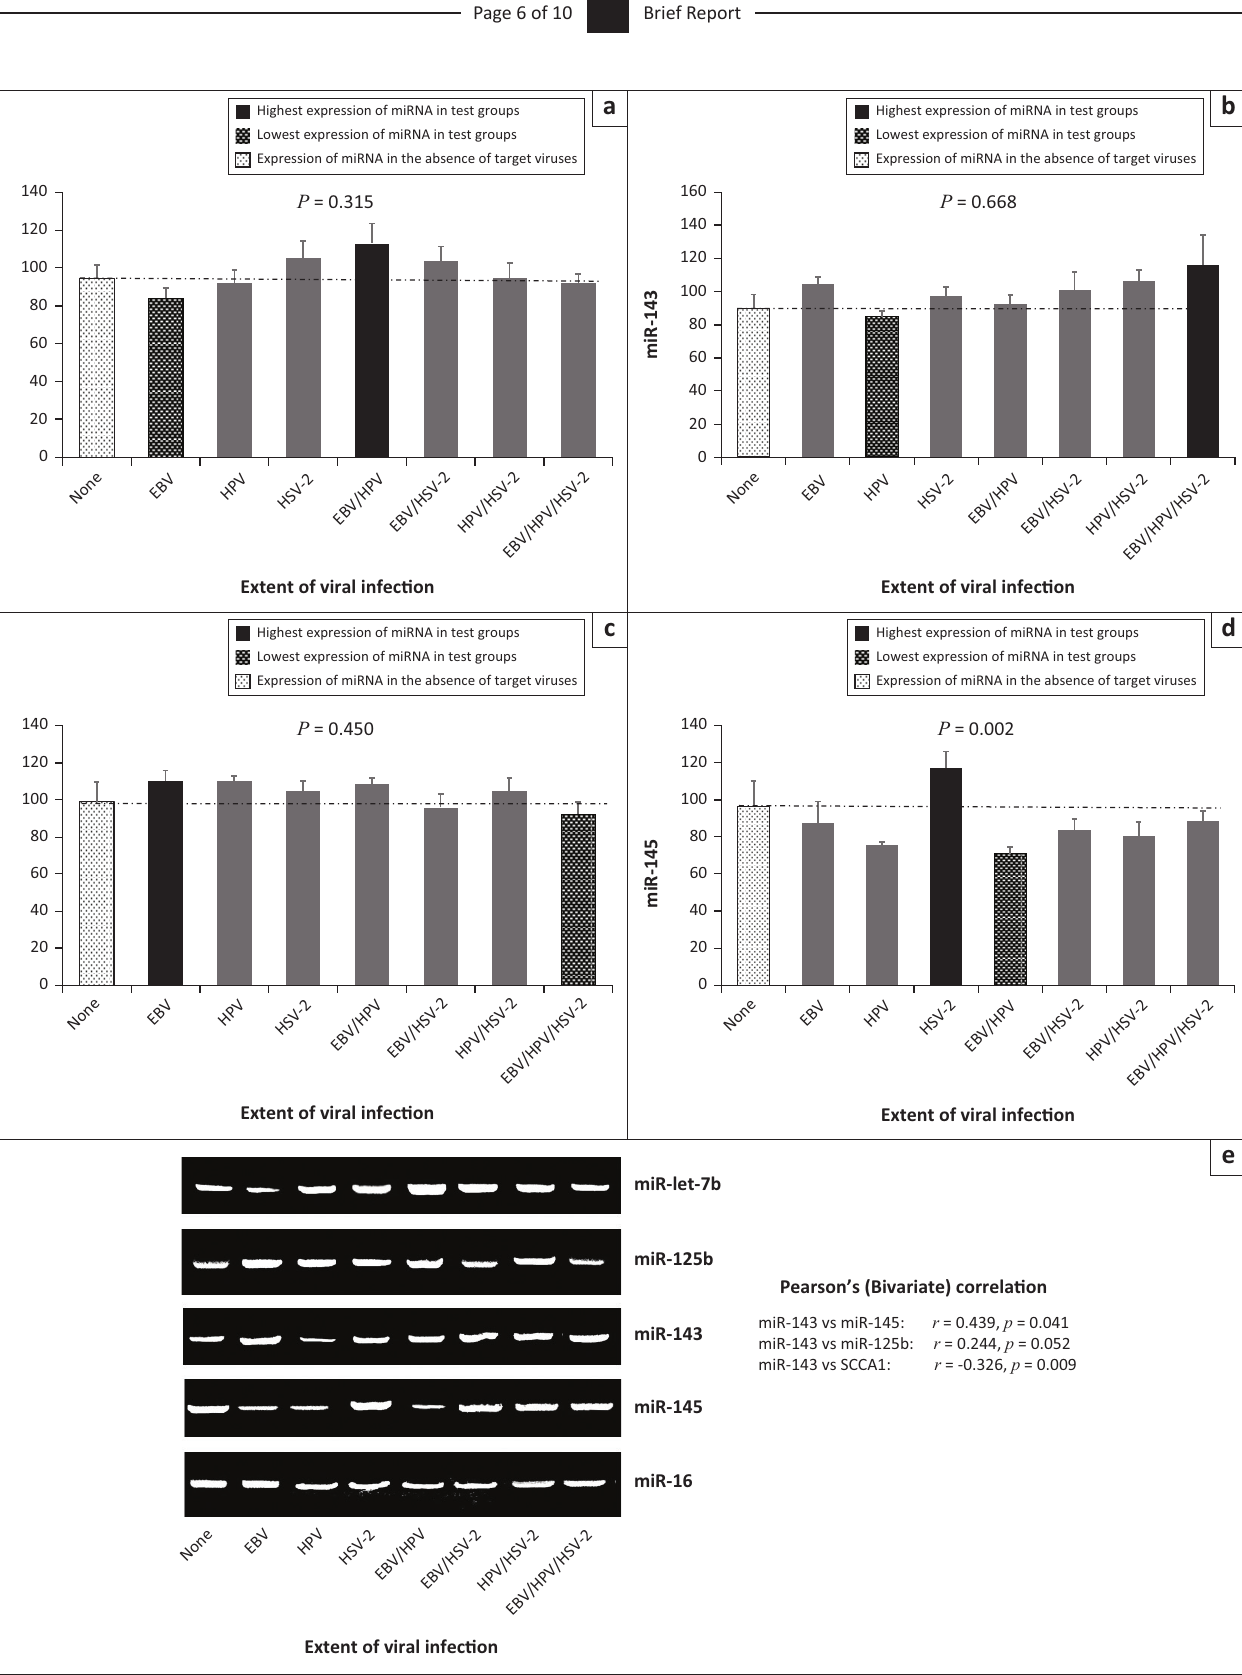
None, control; EBV, Epstein-Barr virus; HSV-2, herpes simplex virus 2; HPV, human papillomavirus; SCCA1, squamous cell carcinoma antigen 1. FIGURE 2: Relative expression of tumour suppressor miRNAs in individuals with and without viral infection, Ogun State, Nigeria, 2018. (a) miR-let-7b expression was higher among participants with EBV and HPV bi-infection and lower among participants with EBV mono-infection; (b) miR-143 expression was higher among participants with EBV, HPV and HSV-2 tri-infection and lower among participants with HPV mono-infection; (c) miR-125b expression was higher among participants with EBV mono- infection and lower among participants with EBV, HPV and HSV-2 tri-infection; (d) miR-145 expression was higher among participants with HSV-2 mono-infection and lower among participants with EBV and HPV bi-infection (d); (e) snapshots of gel amplicons of tumour suppressors and normalising gene (miR-16) based on viral status (plotted as